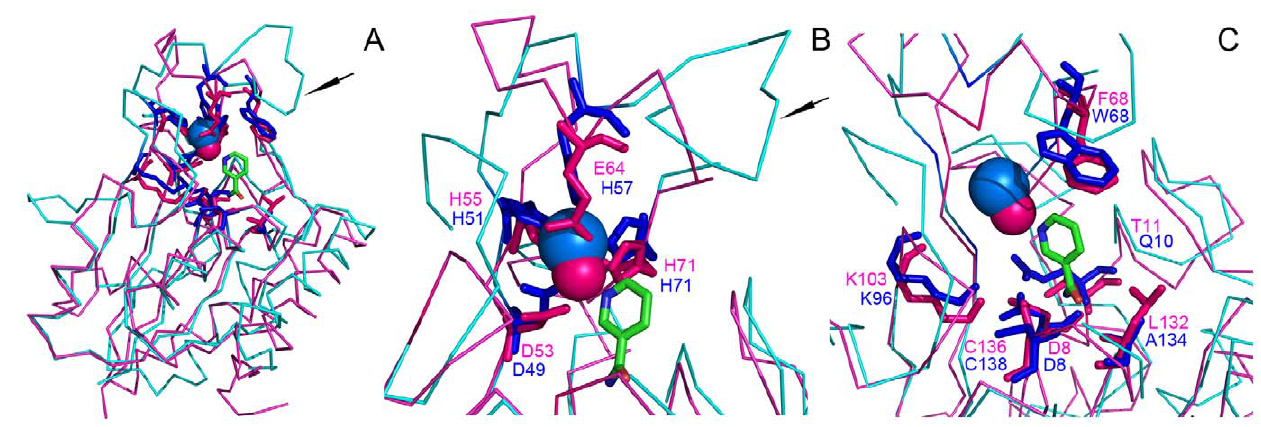
Figure 5. Structural alignment of crystallized SpNIC and crystallized M.tuberculosis MtPncA. A) Monomer of SpNIC is represented in pink and monomer of MtPncA in blue. Fe 2 + and Zn 2 + are represented as blue and pink spheres, respectively. NAM is colored in green. B) Residues interacting with the metal ion. C) Residues forming the active site cavity and interacting with NAM.